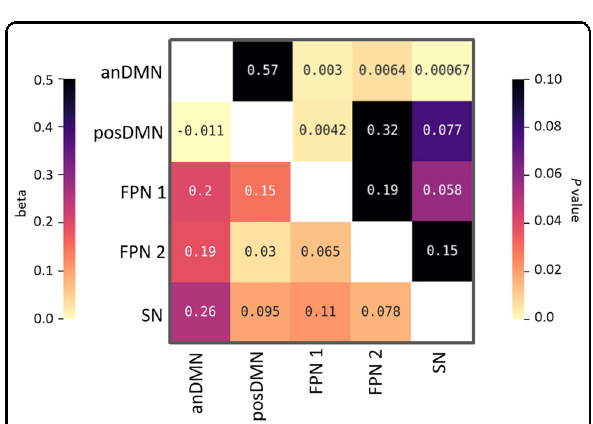
Fig. 3 Correlation matrix illustrating increased functional connectivity between resting-state networks under psilocybin compared to placebo (psilocybin > placebo). The left half of the matrix refers to the beta values, and the right half of the matrix refers to the p